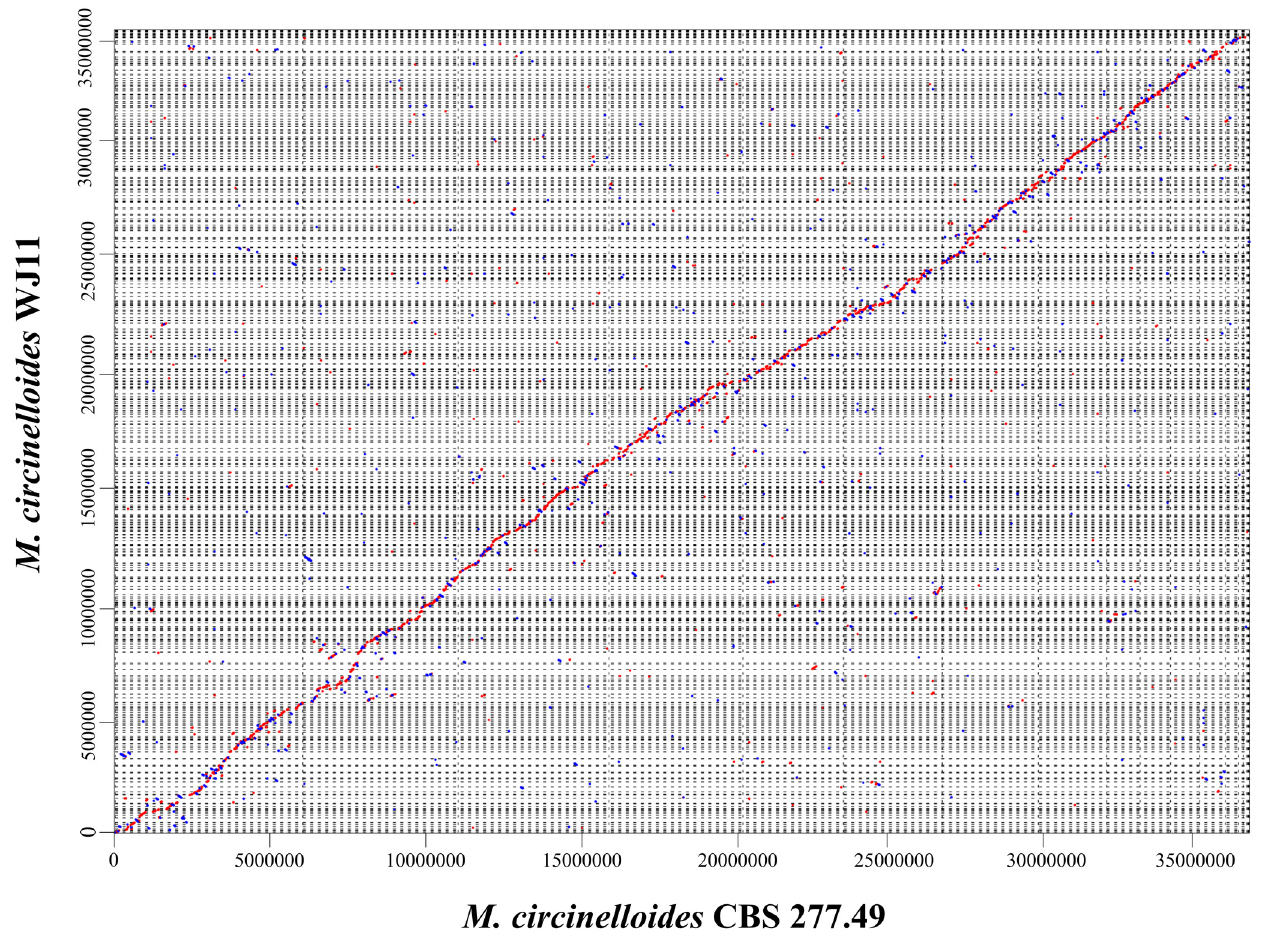
Fig 2. MUMmer-based genomic display between M . circinelloides WJ11 and CBS 277.49. Plus-strand matches are slanted from bottom left to upper right and are shown in red. Minus-strand matches are slanted from upper left to lower right and are shown in blue. The basepair window is at least 200 bp and the similarity ratio per dot is more than 50%. Numbers above the map indicate nucleotide